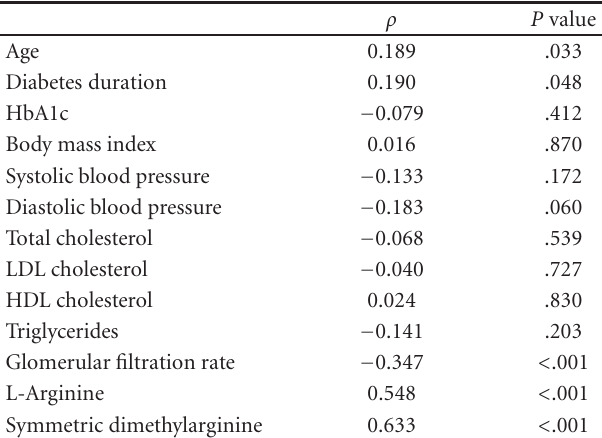
Table 2: Spearman correlations of ADMA with other